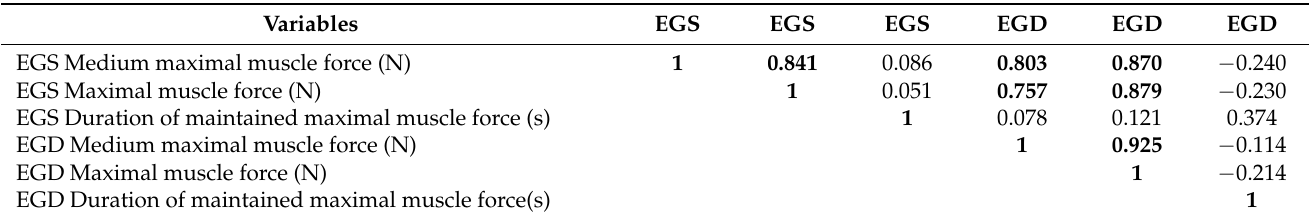
Table 15. Pearson correlation between muscle parameters of left and right knee extensors.